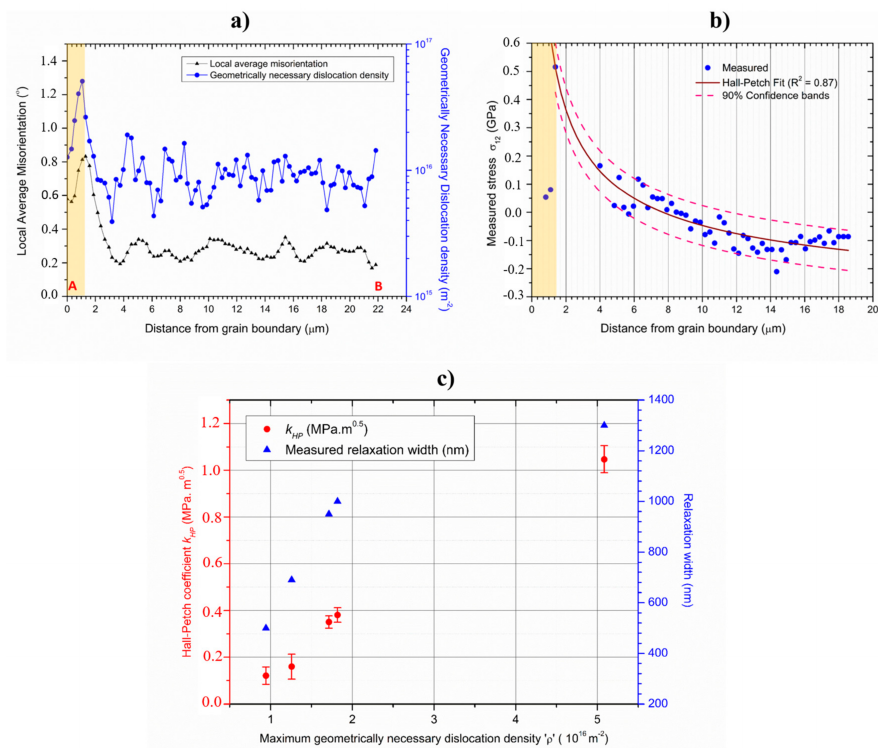
Figure 1. ( a ) Local misorientation and stored dislocation densities in the vicinity of the grain boundary; ( b ) corresponding residual stress profile as a function of distance from the grain boundary; ( c ) variation of k HP and relaxation width with the peak GND density measured in the vicinity of different grain boundaries (adapted from ref.